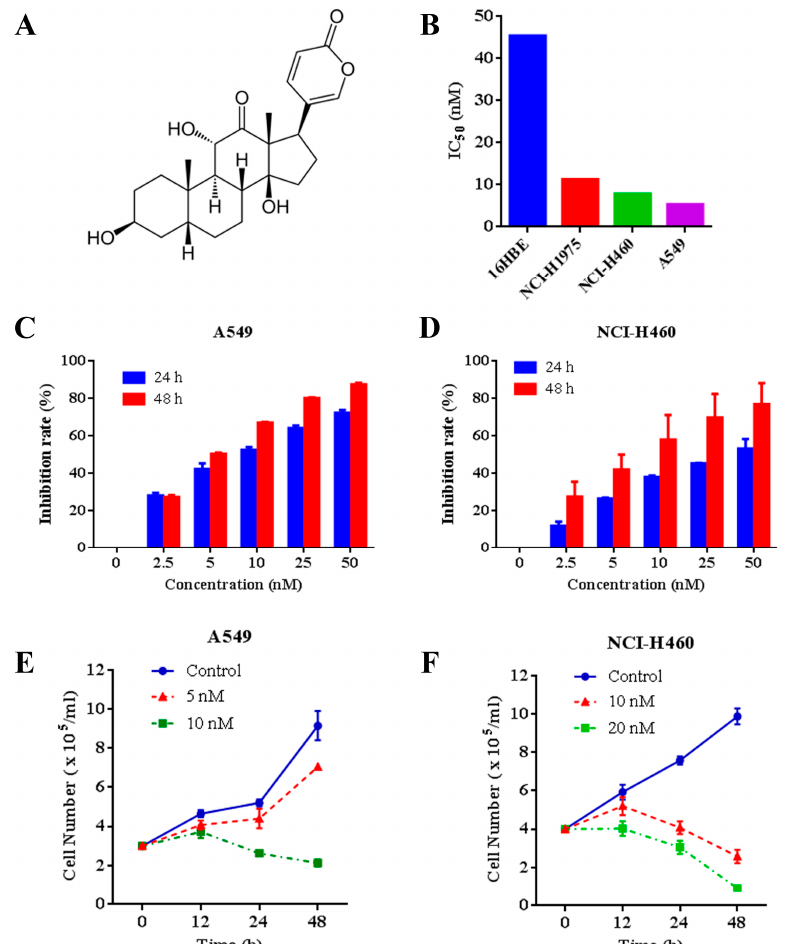
Figure 1. Arenobufagin decreases the cell viability in A549 and NCI-H460 cells. ( A ) The chemical structure of arenobufagin; ( B ) The IC 50 values of arenobufagin for indicated cell lines; ( C ) The inhibitory effects of arenobufagin on A549 cells analyzed by 3-(4,5-dimethylthiazol-2-yl)-2,5-diphenyltetrazolium bromide (MTT) assay; ( D ) NCI-H460 cells were treated with various concentrations of arenobufagin for 24 and 48 h. MTT assays were conducted to measure the cell viability; ( E ) A549 cells were treated with or without arenobufagin for indicated time points, and analyzed by trypan blue exclusion assay; ( F ) Inhibitory effects of arenobufagin on cell viability of NCI-H460 cells measured by trypan blue exclusion assay.